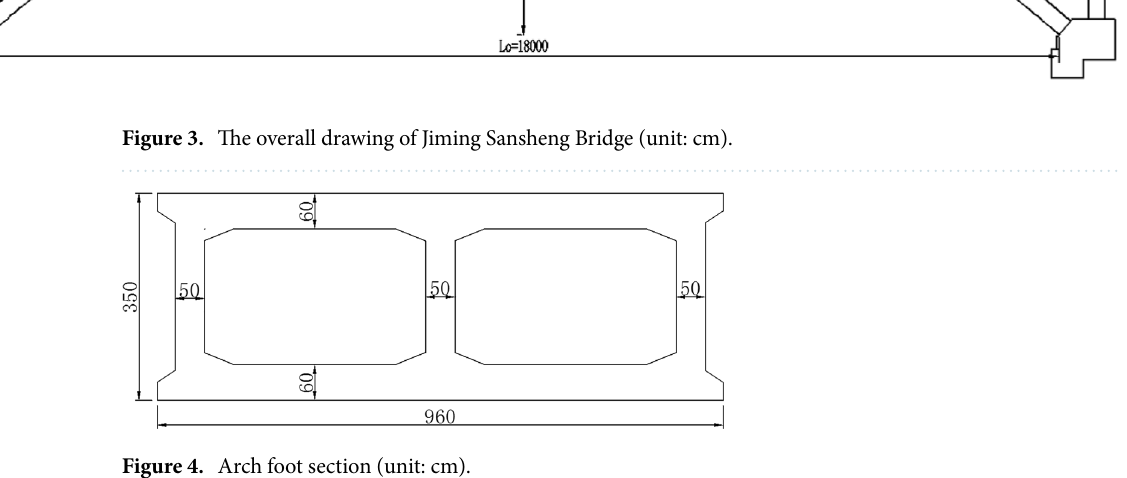
Figure 4. Arch foot section (unit: